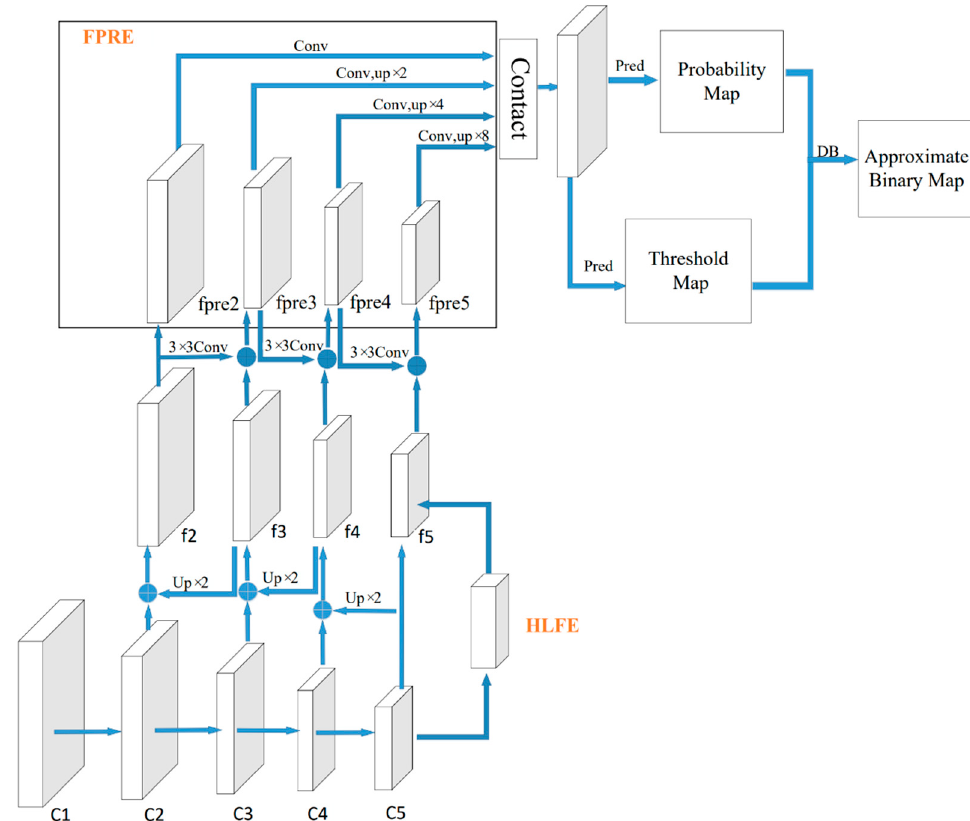
Figure 5. Network structure diagram of improved DBNet model.